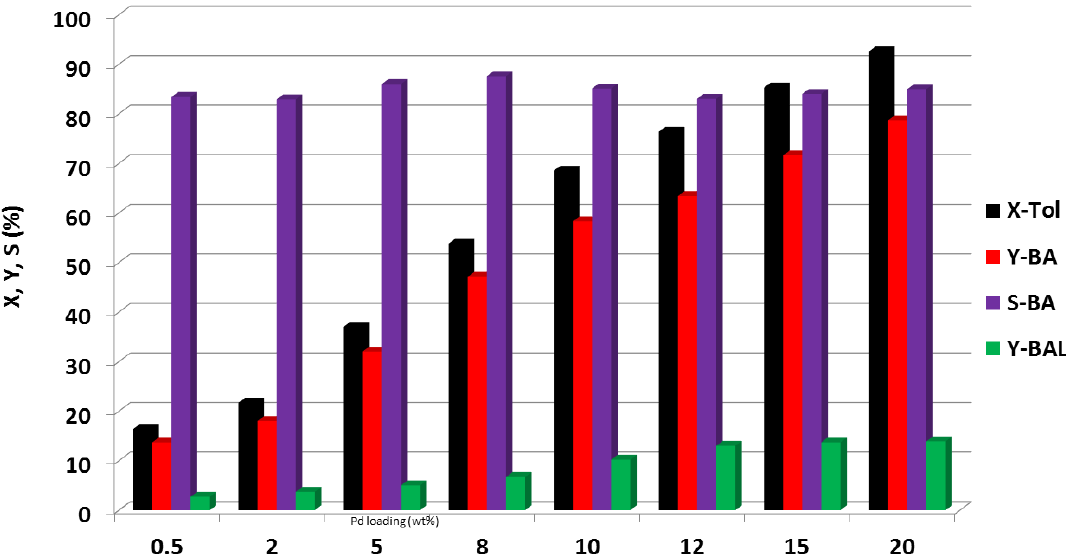
Figure 6. Effect of Pd loading on the catalytic performance of x Pd-8% Sb/TiO 2 catalyst (Reaction conditions: Tol:AcOH:O 2 (air):Ar = 1:4:3(15):4; GHSV = 2688 h − 1 ; τ = 1.34 s; T = 210 °C; P = 2 bar) [79].